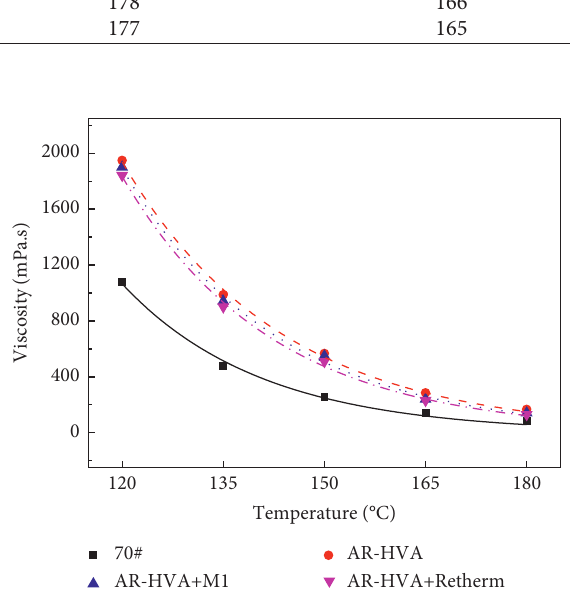
Figure 5: Viscosity-temperature curves of different